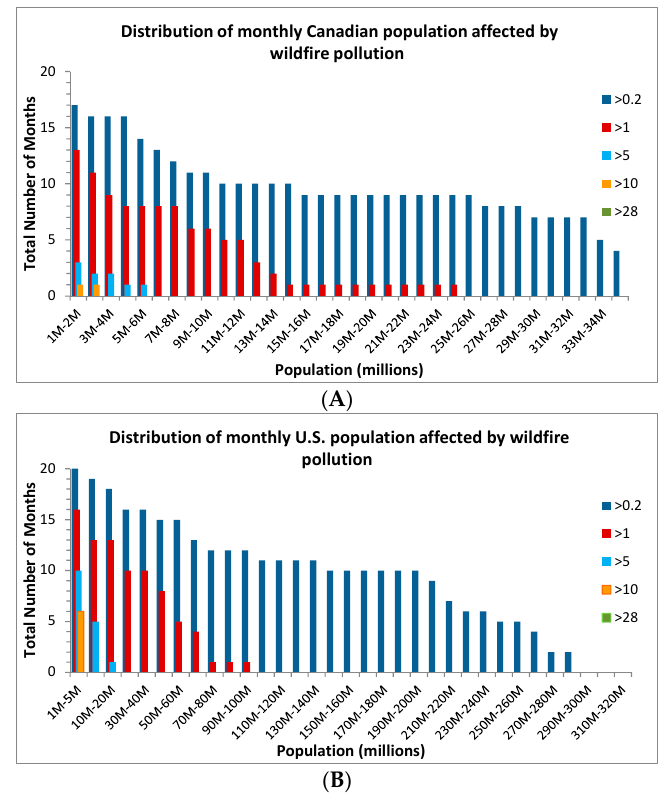
Figure 7. Cumulative distribution of number of months with the portions of the Canadian ( A ) and U.S. ( B ) population affected by monthly fire-PM 2.5 above five PM 2.5 concentration thresholds for four five-month wildfire seasons (2013–2016).